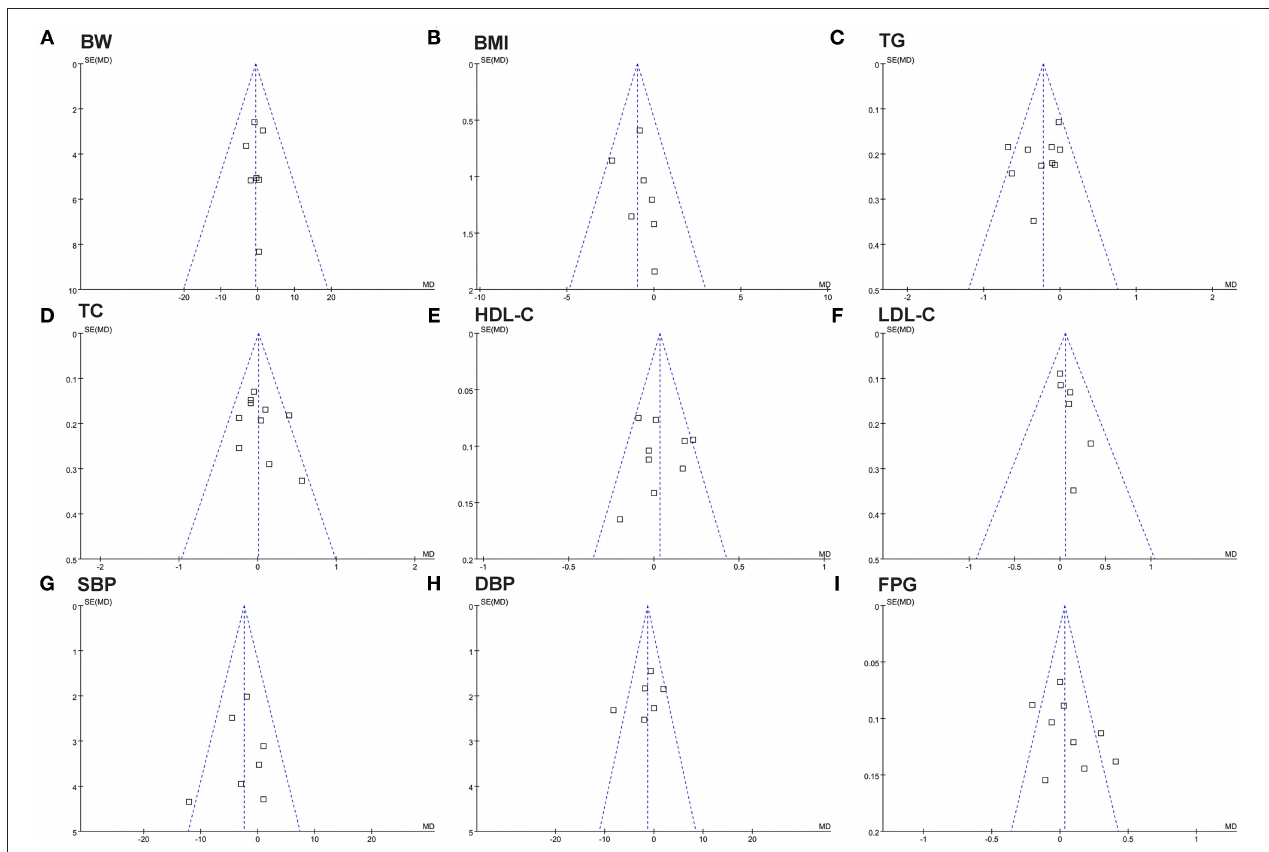
FIGURE 2 | Funnel plots for the meta-analysis evaluating the influence of fish oil supplementation on obesity and other cardiometabolic risk factors in overweight or obese children. (A) Body weight (BW); (B) BMI; (C) TG; (D) TC; (E) HDL-C; (F) LDL-C; (G) SBP; (H) DBP; (I)